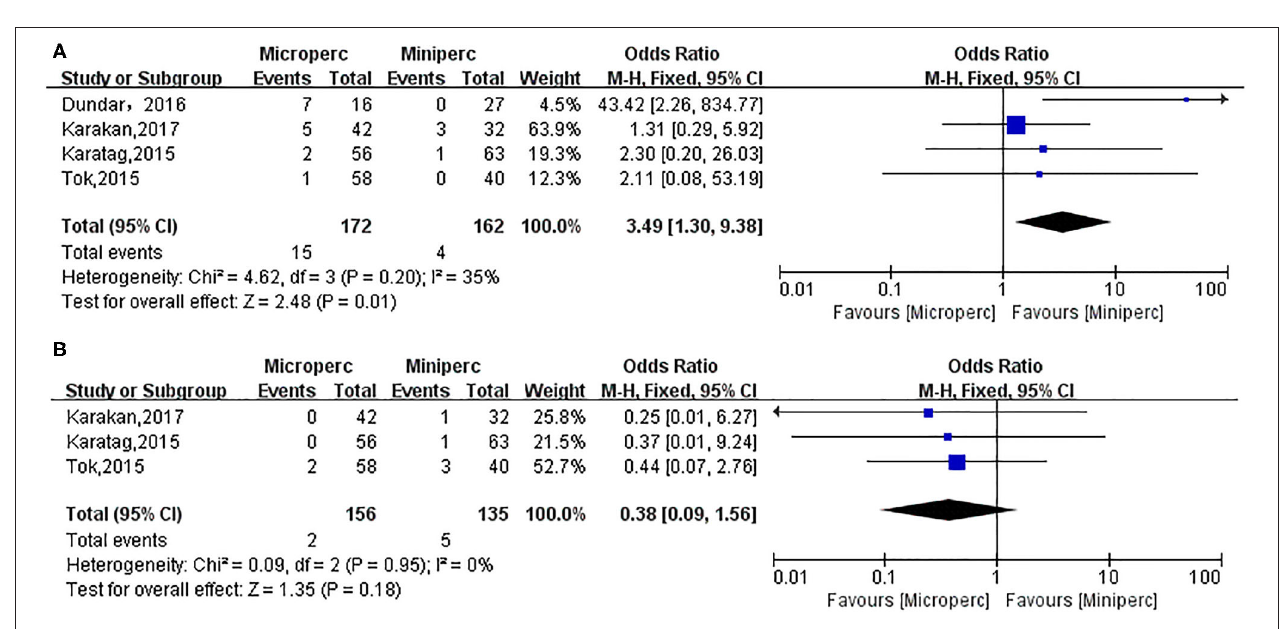
FIGURE 5 | Forest plot for hemoglobin drop.